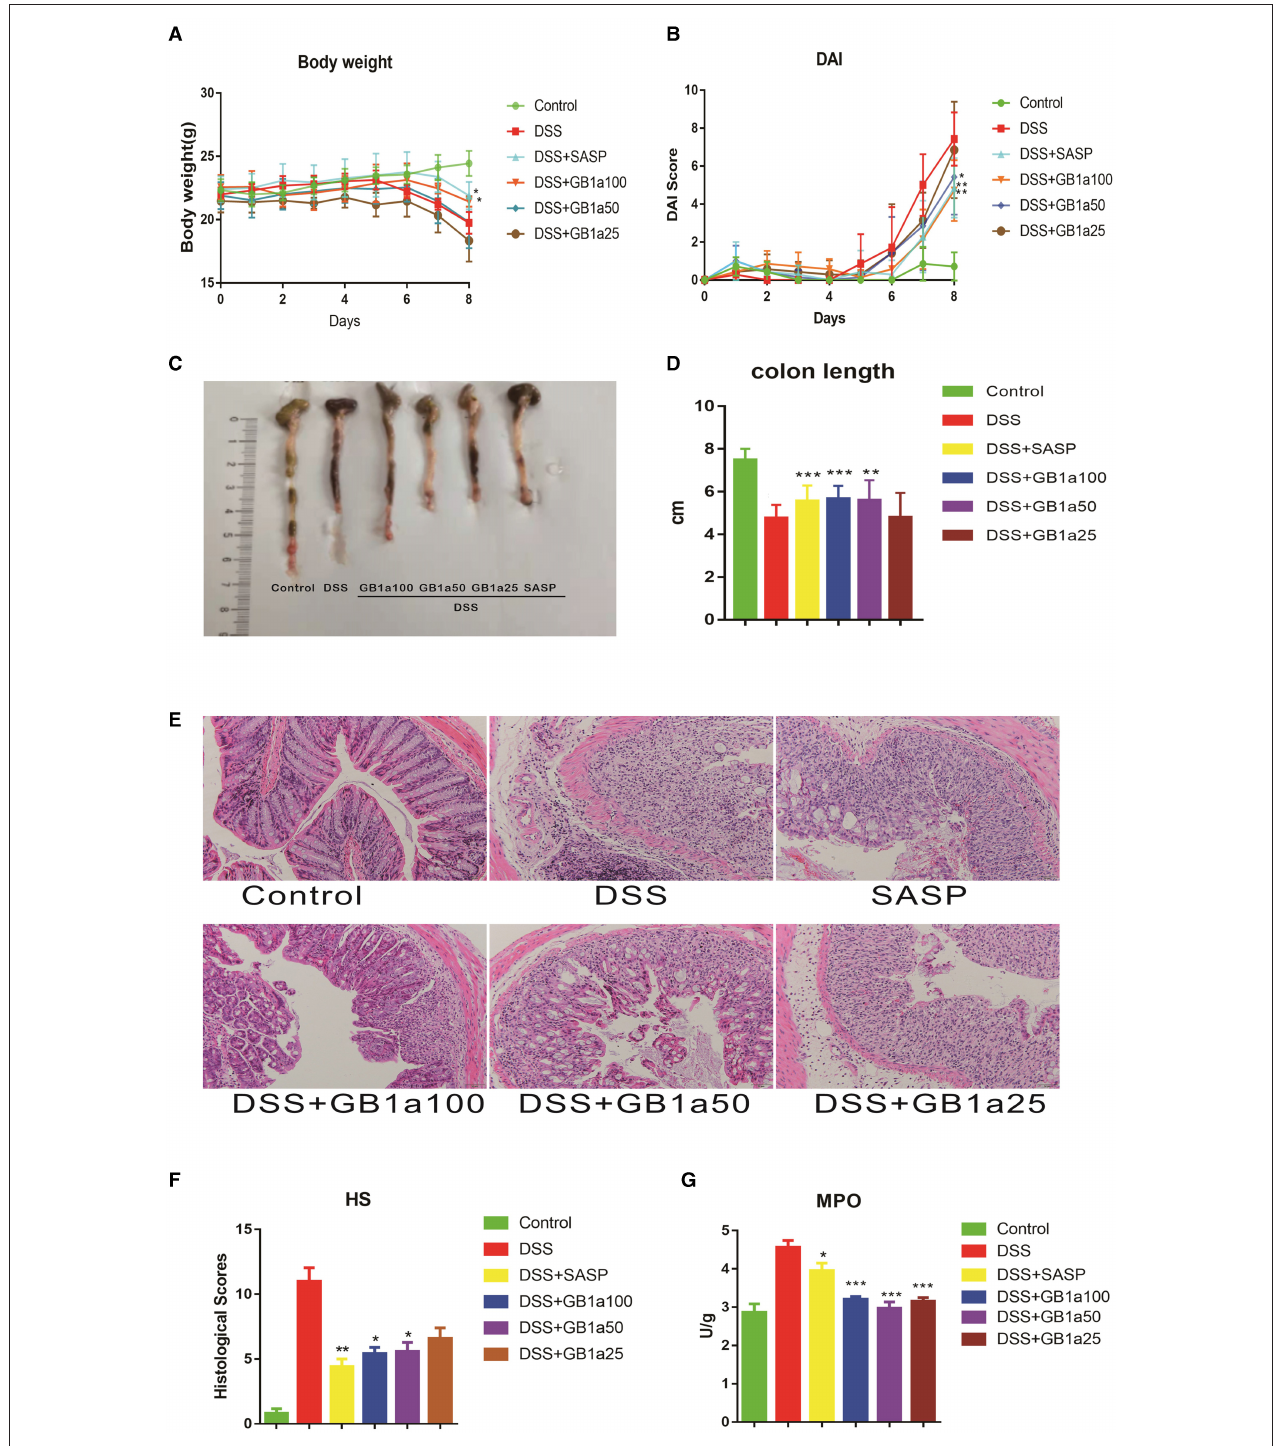
FIGURE 3 | GB1a alleviates the symptoms of DSS-induced UC in mice. (A–D) GB1a treatment ameliorated DSS-induced body weight loss (A) , DAI scores raising (B) , colon shortening (C,D) . (E,F) GB1a attenuates colonic pathological damage in UC mice (E) and decreased the histological scores of the colon tissues (F) . (G) GB1a intervention significantly reduced the serum MPO activity in UC mice. Data are presented as means ± SD ( n = 7/group). * p < 0.05, ** p < 0.01, and *** p < 0.001 vs. the DSS-incubated group.